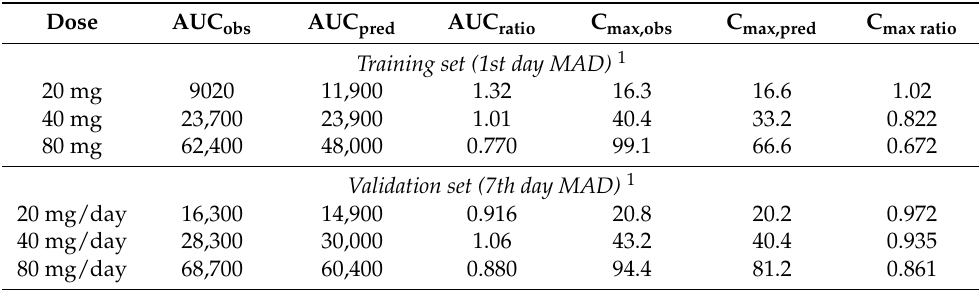
Figure 2. Observed and simulated time-concentration profiles for fexuprazan at the first doses of 20 mg ( A ), 40 mg ( B ), and 80 mg ( C ) in humans. Solid lines represent optimized simulations or model fitting. Closed circles ( ● ) represent observed data [10,22] . Data are means ± SD for eight healthy volunteers. Table 4. Summary of AUC last (ng · min/L) and C max (ng/mL) ratios of fexuprazan in the two